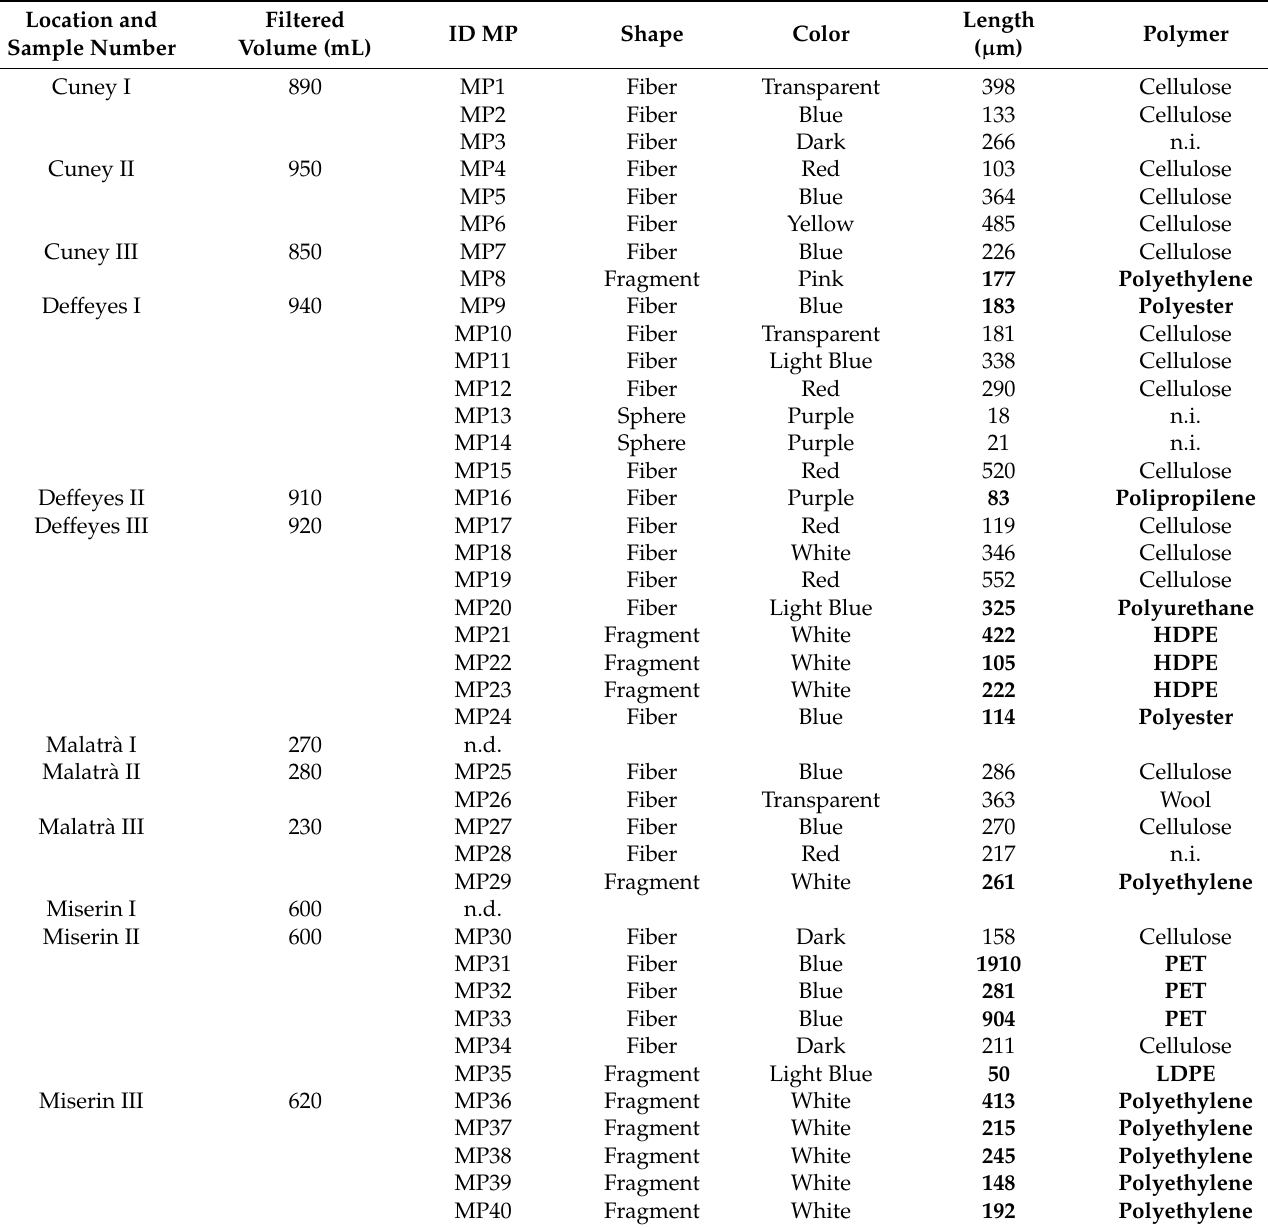
Table 2. Characteristics of putative MPs isolated from snow samples collected at four locations in the Aosta Valley (Western Italian Alps). Plastic polymers are reported in